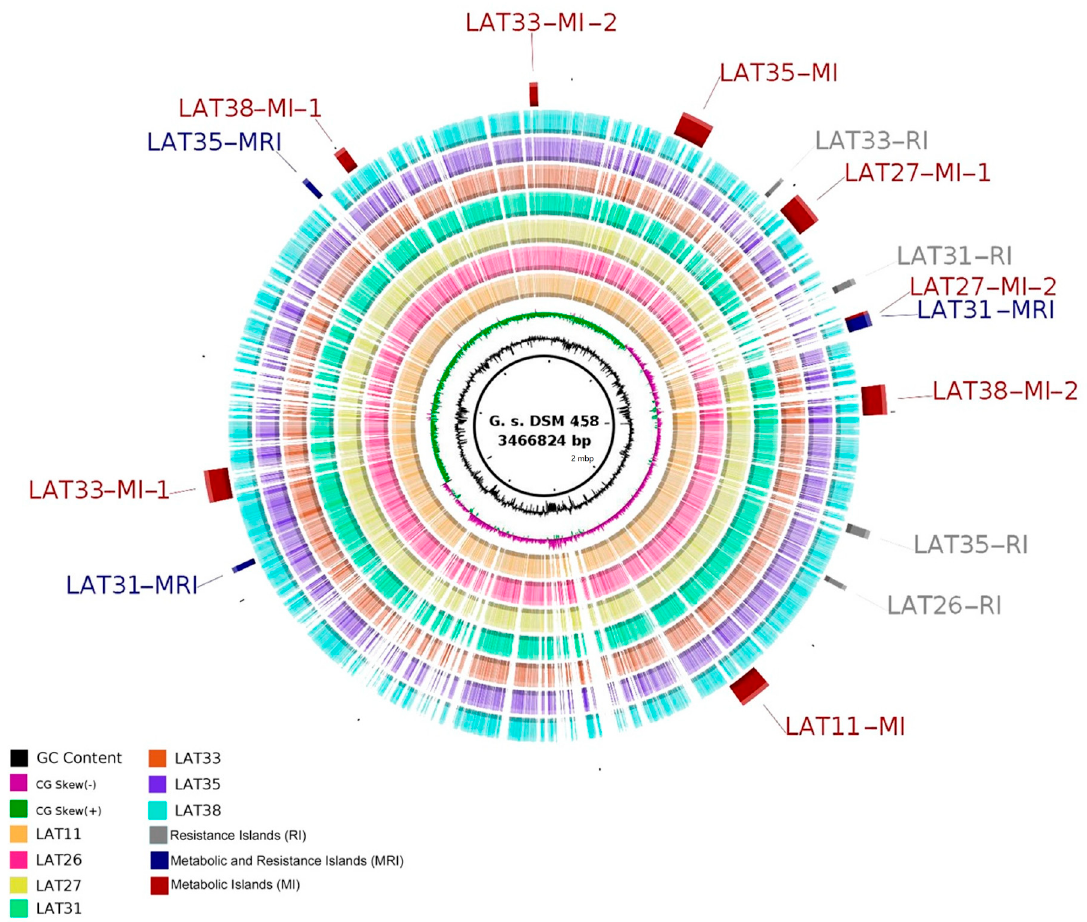
Figure 3. Circular visualization of the genome comparisons of Anoxybacillus strains and Geobacillus stearothermophilus DSM 458 (reference), created by BRIG. The inner black circle contains the complete reference genome (strain DSM 458), and the intensity of each color indicates the similarity of that strain with the reference genome.